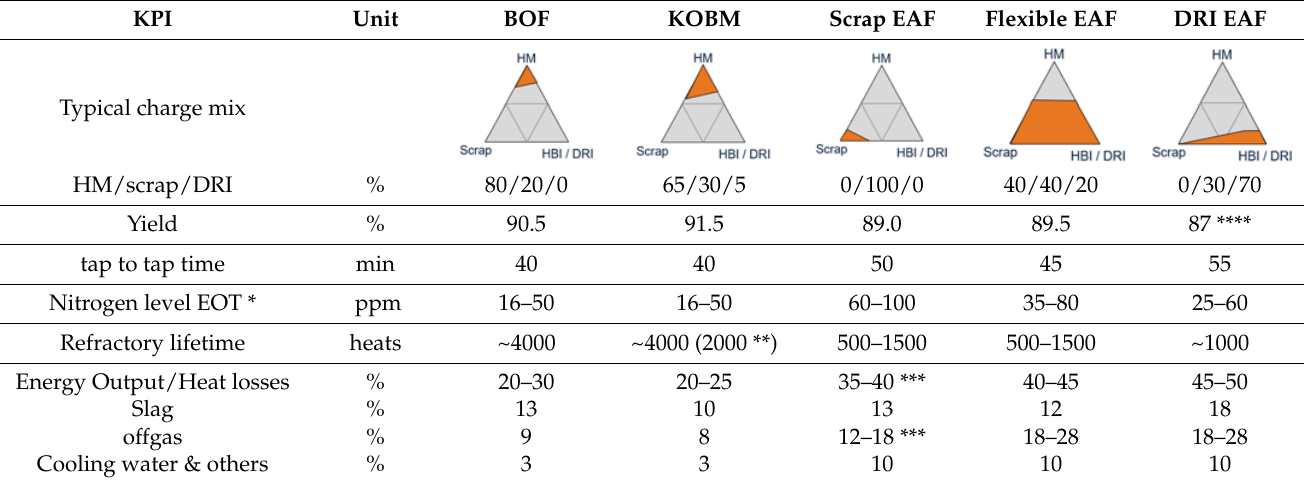
Table 1. Comparison of typical reference data from BOF and EAF operation.